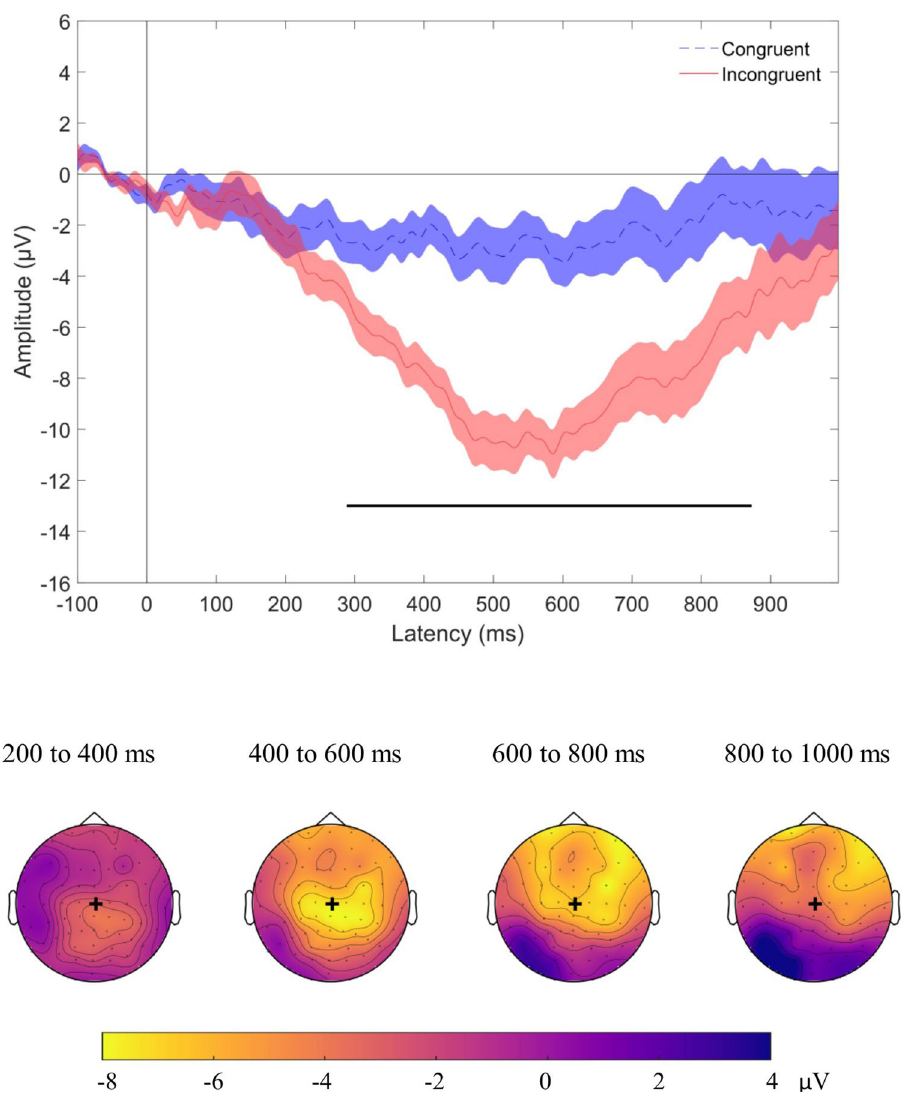
Figure 5. Group N400 effect. Top panel displays grand average ERPs (n = 20), with congruent (dashed blue) and incongruent (solid red) conditions for the signal averaged over our region of interest. Shading indicates standard error of the mean. Time points at which there was a statistically significant difference between conditions are indicated with a solid black line under the plot (p < 0.05, after cluster correction for multiple comparisons). Bottom panel illustrates the topographic map of the N400 effect (mean magnitude of unrelated minus related condition) from 200 to 1,000 ms after target onset in the group. Yellow colours indicate a negative difference between the two conditions (incongruent more negative than congruent), while blue colours indicate a positive difference. These maps are for illustrative purposes and are not thresholded for significance. Black + indicates Cz location. The N400 effect was distributed over central and centro-frontal